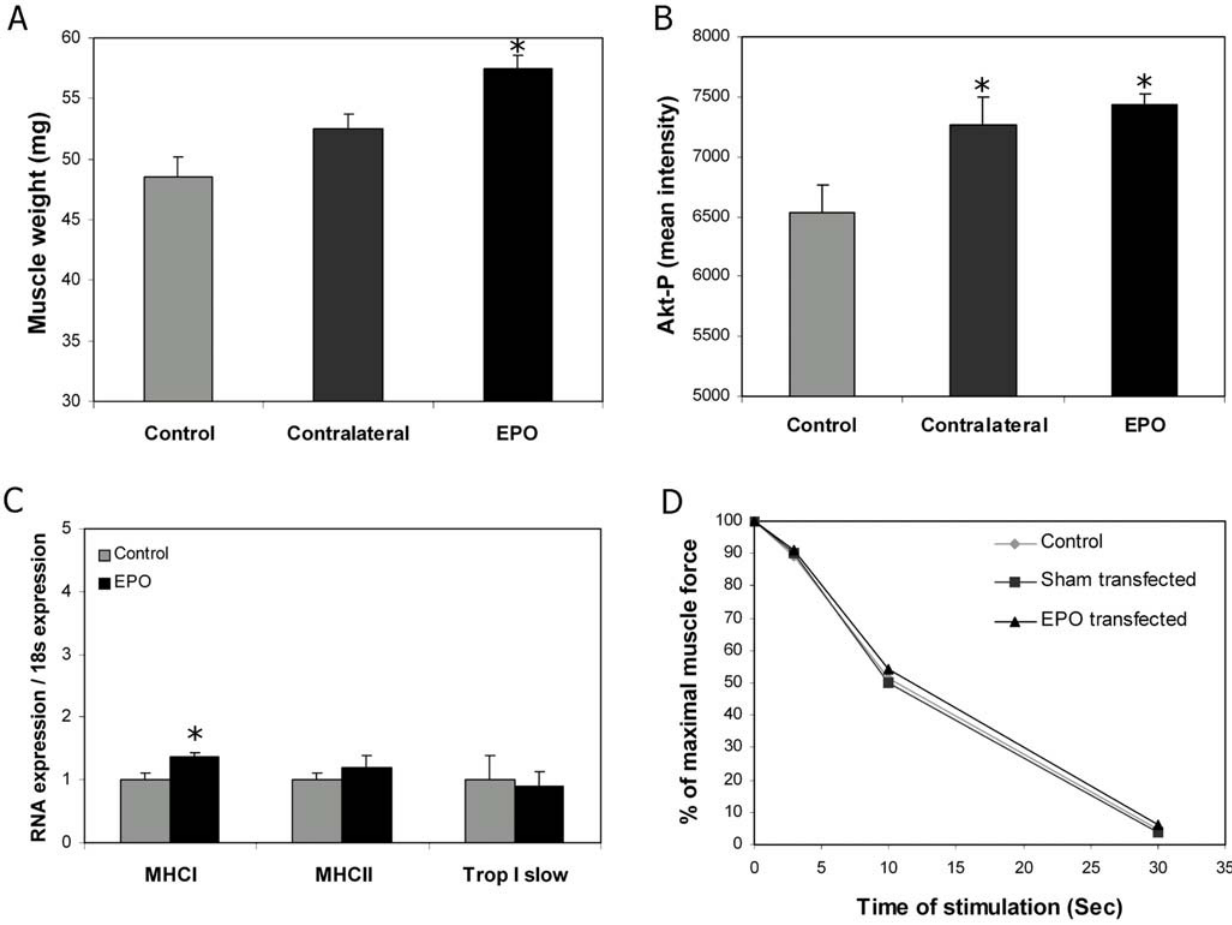
Figure 2. EPO expression is associated with muscle hypertrophy. The muscle hypertrophic response was evaluated 5 weeks after DNA electrotransfer in mice placed on the regular chow diet. Each group consisted of 8 mice. For A and B, data from muscles from control mice (control), the contra lateral leg of the EPO transfected mice (contralateral), and the EPO transfected leg (EPO) are shown. Means 6 SEM are depicted. A) Total muscle weight, B) phosporylated Akt determined by Western Blotting, C) expression of muscle fibre protein (Q-PCR) in control and EPO transfected muscles, and D) muscle stamina in % of the control leg. Statistical significance was tested by Student’s t-test with Bonferroni corrections for multiple testing. * indicates significance at p , 0.05.